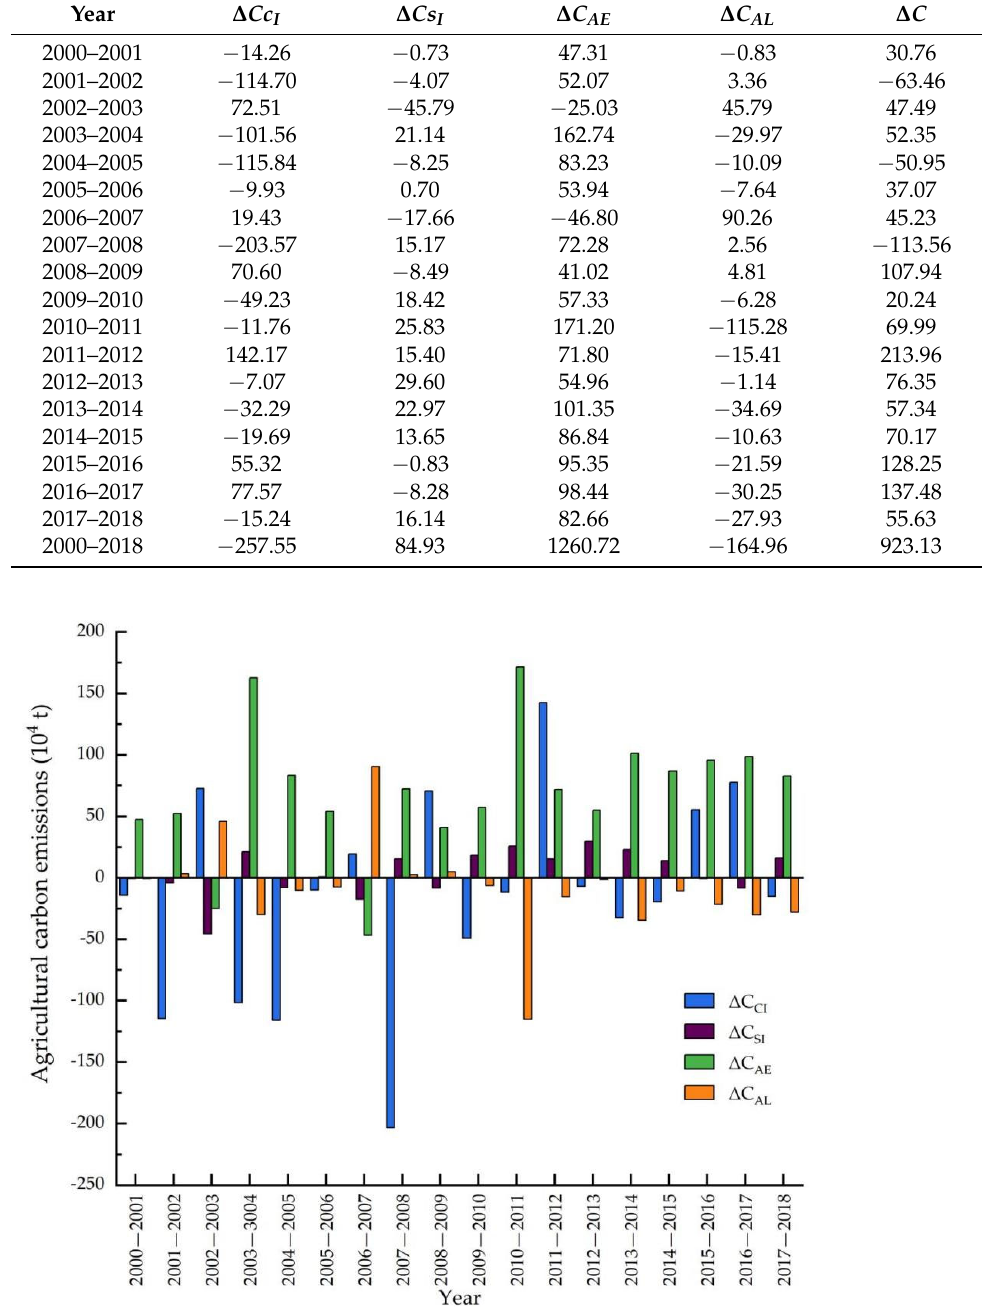
Figure 5. Contributions of each factor to agricultural carbon emissions in Heilongjiang province